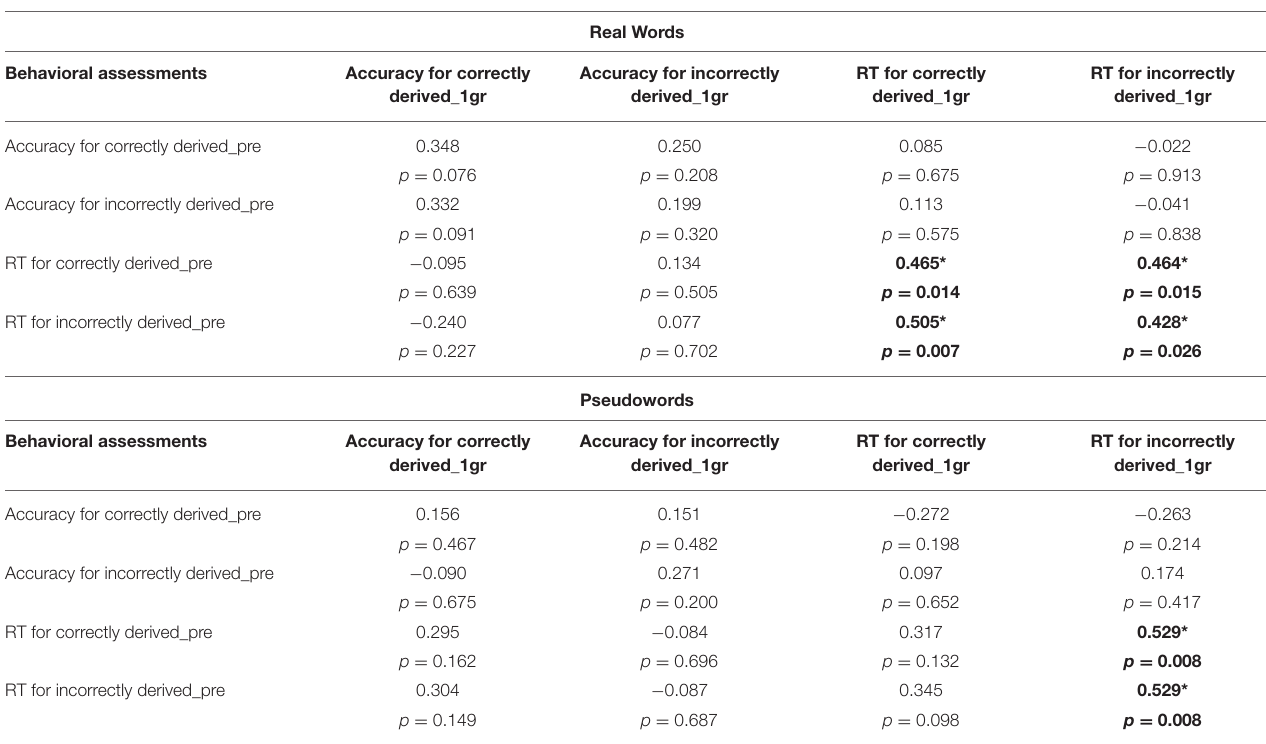
TABLE 5 | Correlations (Spearman’s) between the pre-school children’s behavioral performance during the MEG morphological task and the first grade children’s behavioral performance during the MEG morphological task for real words ( N = 27 pre-school children with and without risk, N = 27 first grade children with and without risk) and for pseudowords ( N = 23 pre-school children with and without risk, N = 23 first grade children with and without